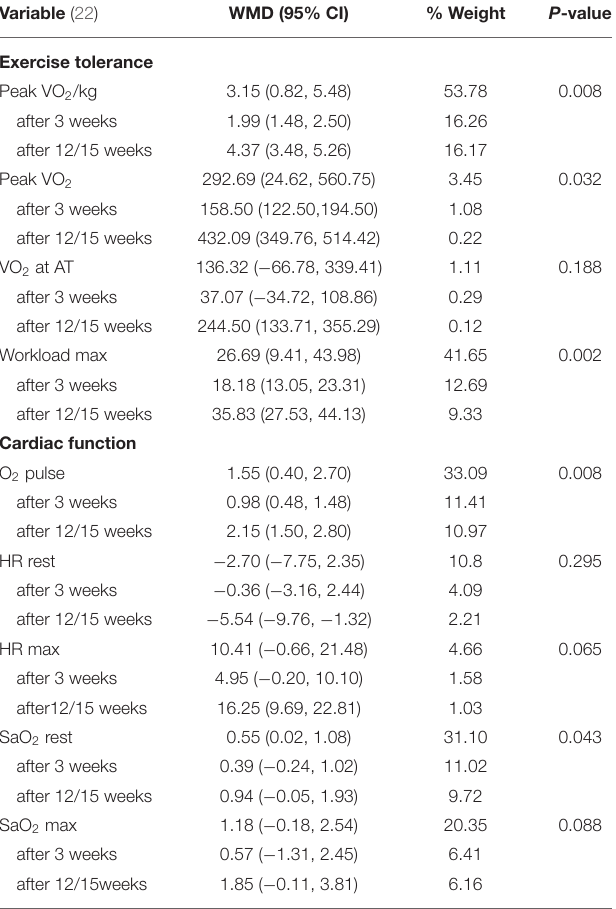
TABLE 2 | Changes in cardiopulmonary exercise testing after exercise training in CTEPH patients with PEA. Variable